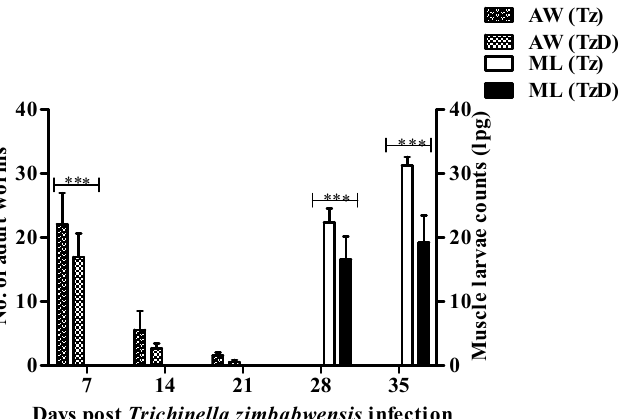
Figure 1. Mean number ( ± SEM) of Trichinella zimbabwensis adult worms (AW) and larvae per gram (lpg) of muscle larvae (ML) recovered from the intestines and muscles of male Sprague Dawley rats infected with T. zimbabwensis (Tz) and male diabetic rats infected with Tz (TzD). Values are presented as means and vertical bars indicate SEM ( n = 6 in each group) and asterisks represent significant differences between the Tz and the TzD groups (*** p < 0.001).